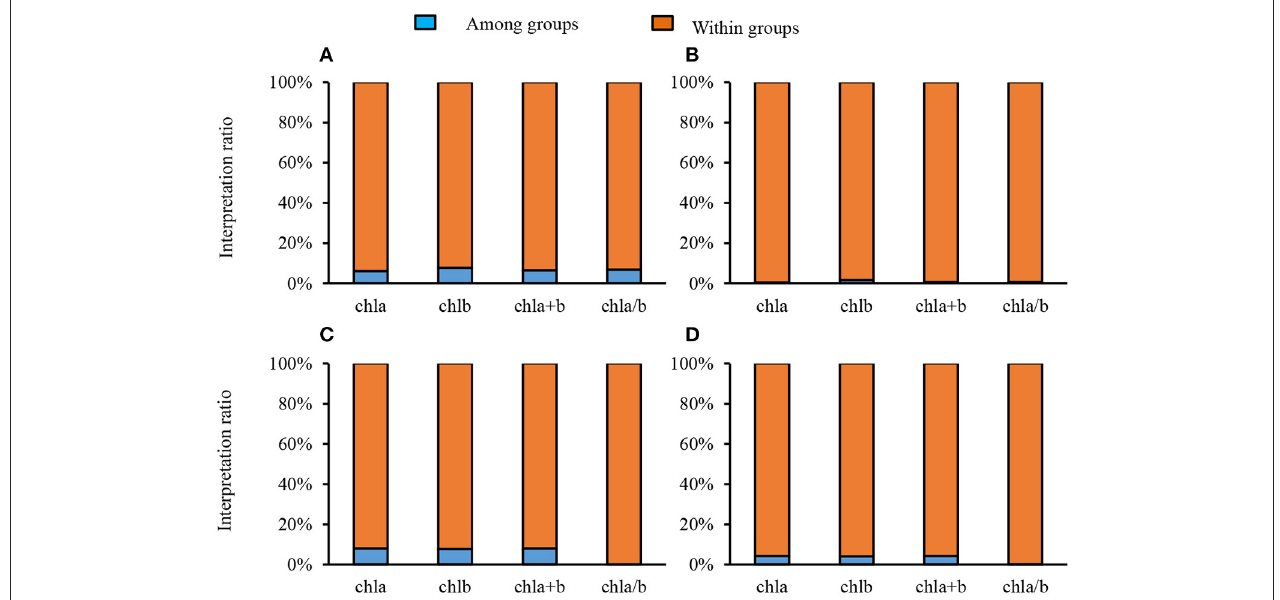
FIGURE 2 | Partitioning the total spatial variance of leaf chlorophyll content in the nine forests (A) , different life forms (B) , different growth forms (C) , and different leaf shapes (D)